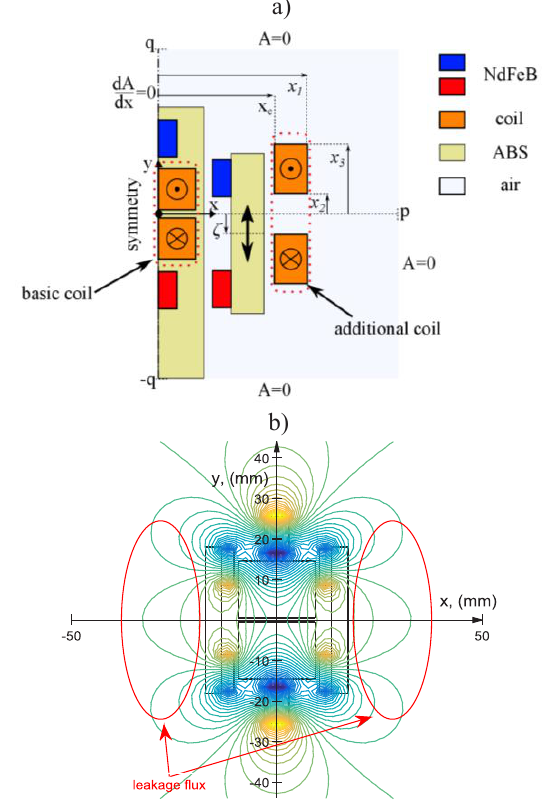
Fig. 1. Considered system: a) schematic diagram b) distribution of magnetic flux lines at displacement of magnets ζ = 0